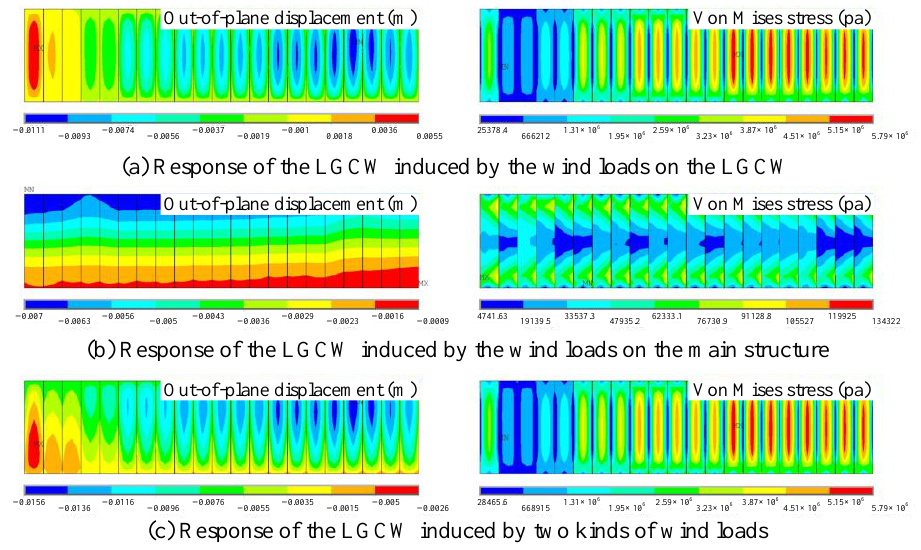
Figure 9. Response distribution of the LGCW at 0°.